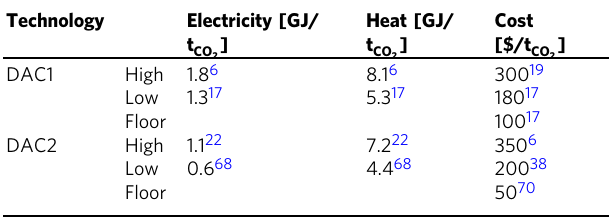
Table 2 Energy and cost assumptions, high and low scenario Technology